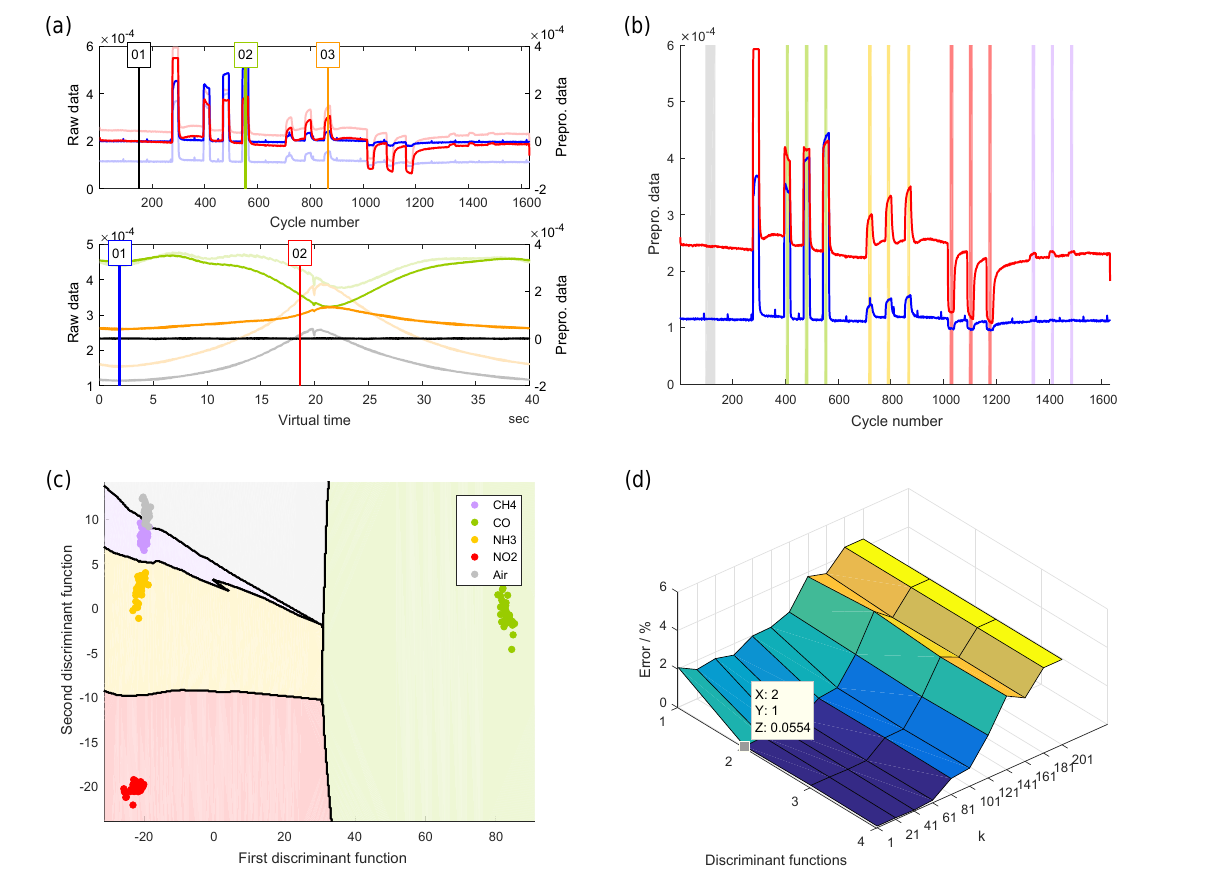
Figure 12. (a) Quasistatic and cyclic signal from the UST GGS1330 gas sensor. The cycles shown are in pure air (black), CO (green), and NH 3 (orange), while the quasistatic signals show the sensor reaction at low (blue) and high (red) temperature. (b) Graphical representation of a grouping for the discrimination of five classes, i.e., four gases and air. (c) Territorial plot of the resulting discrimination with the kNN classifier. (d) A grid search evaluating the model for different numbers of discriminant functions and k values of the kNN